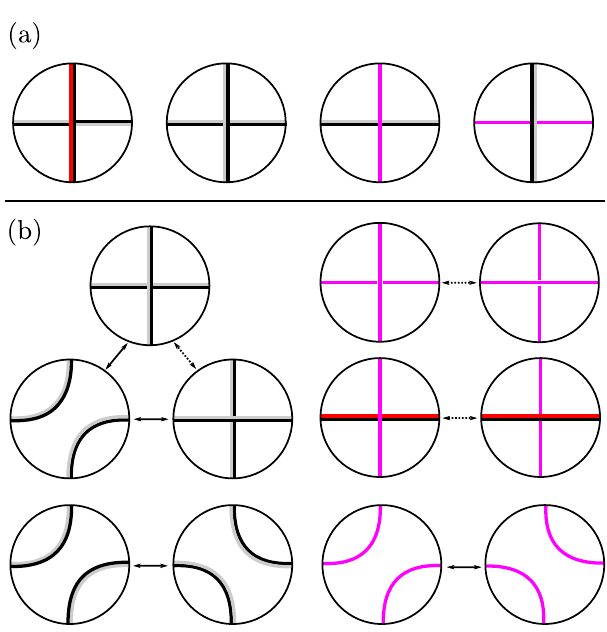
Q 8 -colored links and the evolution of the core topology . A con fi guration of topological vortices is formalized as follows. The spatial extent of the ordered medium is modeled by the three- dimensional euclidean space R 3 . Homotopy theoretically, it makes no difference if R 3 is replaced by the unit ball in R 3 . The cores of the vortices, i.e., the location where the order parameter is not well de fi ned, form a subset L (cid:3) R 3 consisting of loops. In other words, the collection of cores forms a link in R 3 . The order parameter fi eld is modeled by a continuous map Ψ : R 3 n L ! M , where M is the order parameter space. The induced homo- ð R 3 n L ; x Þ ! morphism between the fundamental groups ψ : π 1 0 π as illustrated in Fig. 1. If the second homotopy group Ψ ( x fi ned analogously to the funda- π 2 [ M , 0 )], i.e., the group de mental group but with spheres instead of loops, is trivial, then the group homomorphism ψ retains all the information about the homotopy class 26,27 of Ψ . In fact, the homotopy classes of con- tinuous maps R 3 n L ! M are in one-to-one correspondence with ð R 3 n L Þ ! π ð M Þ up to change of group homomorphisms π 1 1 coordinates, or conjugacy , de fi ned as follows: homomorphisms